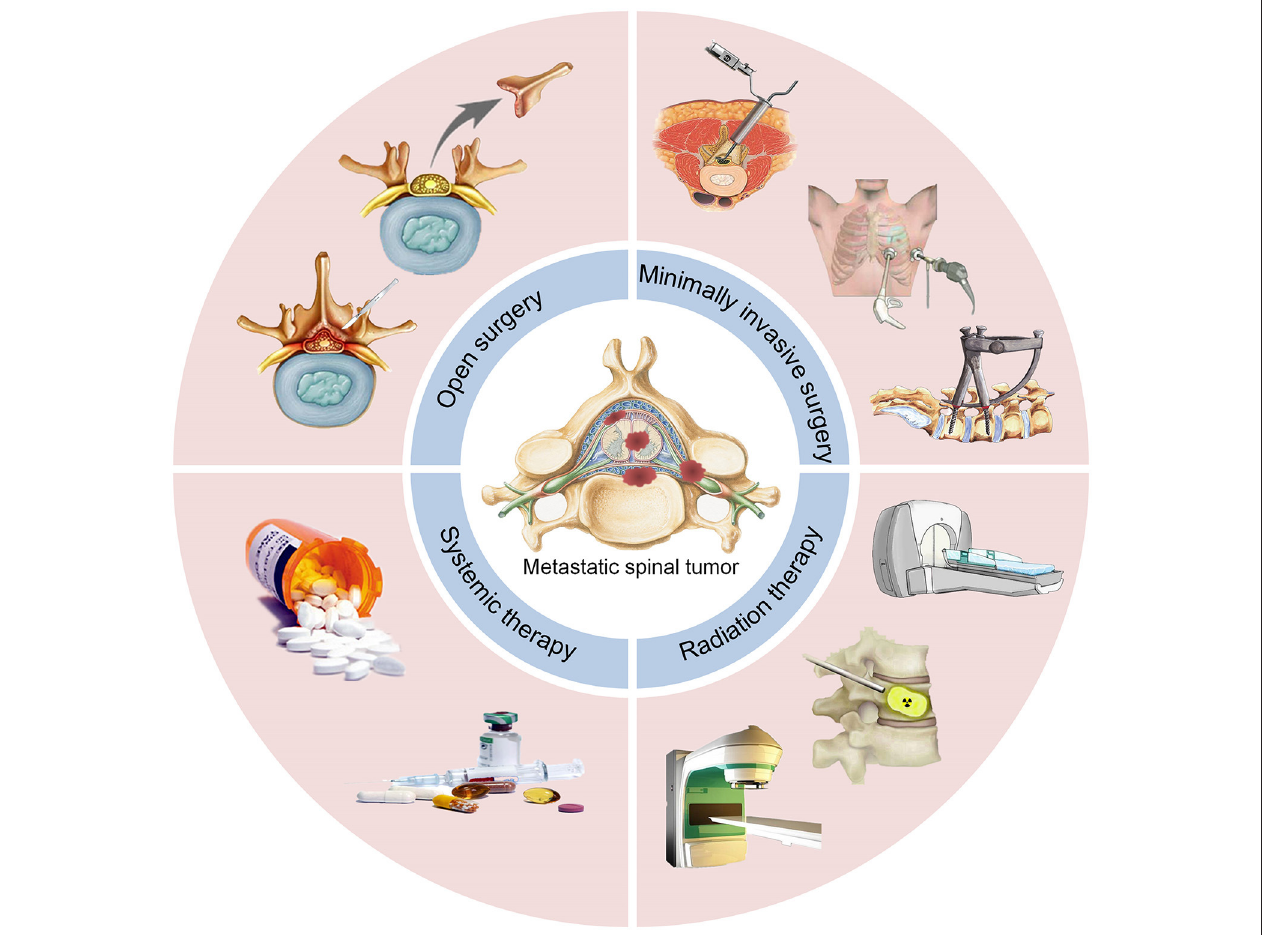
FIGURE 1 | Location and current treatment options for MST. MST, metastatic spinal